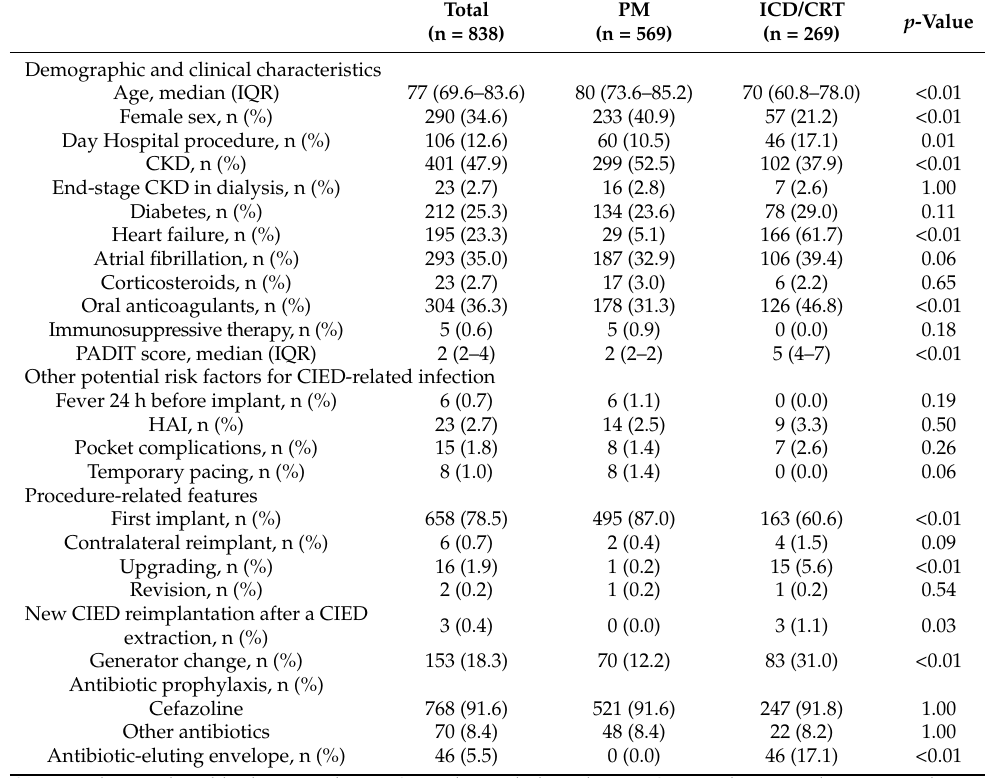
Figure 1. Age distribution in patients with pacemaker (PM) and implantable cardioverter defibrillator (ICD)/cardiac resynchronization therapy (CRT). Table 1. Baseline characteristics of the study cohort.